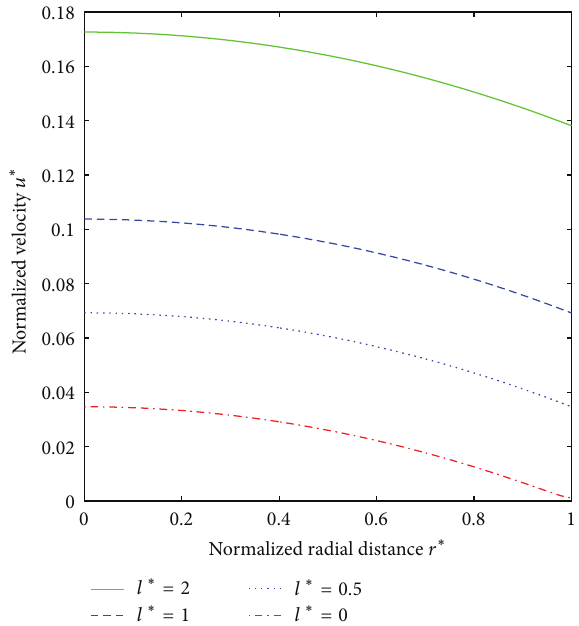
Figure 1: Typical velocity profile of the velocity component due to pressure gradient under different 𝑙 ∗